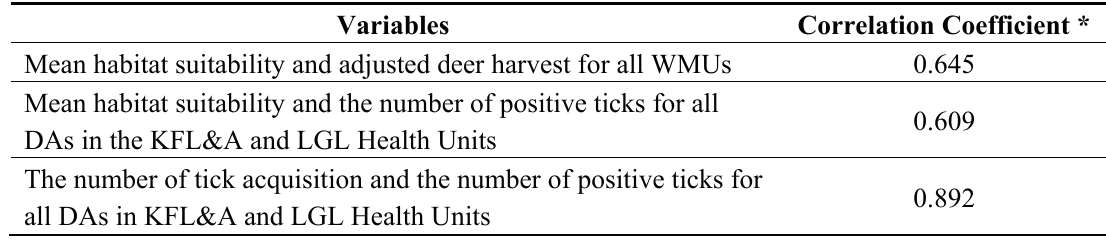
Table 2. Correlation coefficients between variables tested in this study. WMU, wildlife management unit.